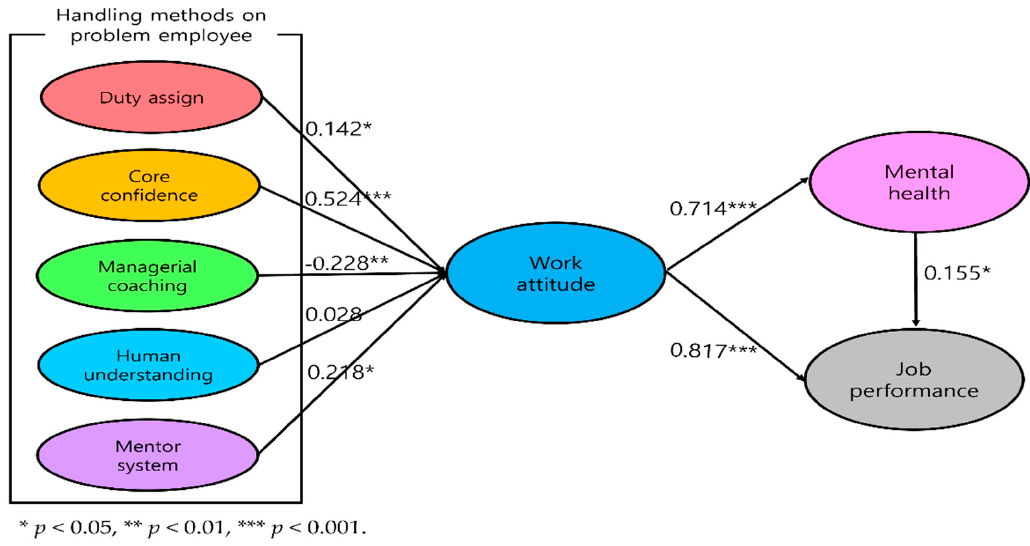
Figure 4. Structural Equation Model Analysis.